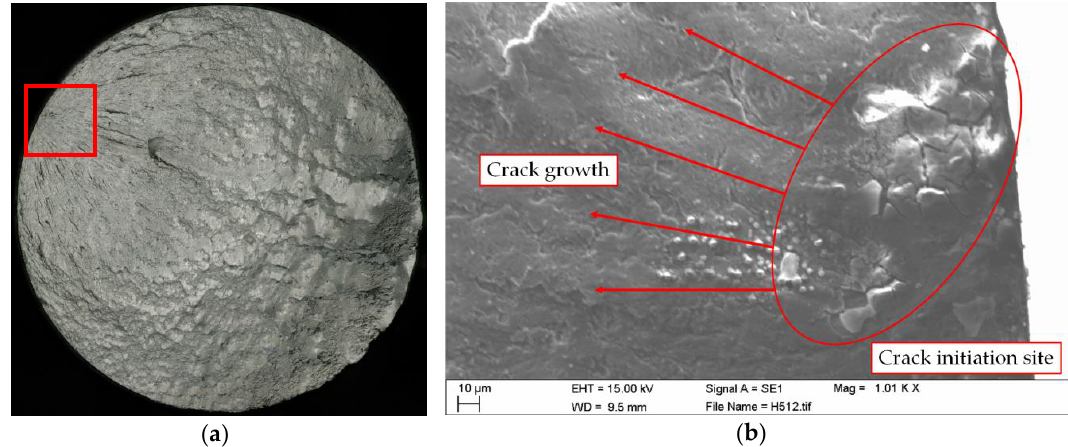
Figure 8. ( a ) Fracture surface of an HIP specimen; ( b ) failure-critical, microstructural inhomogeneity.